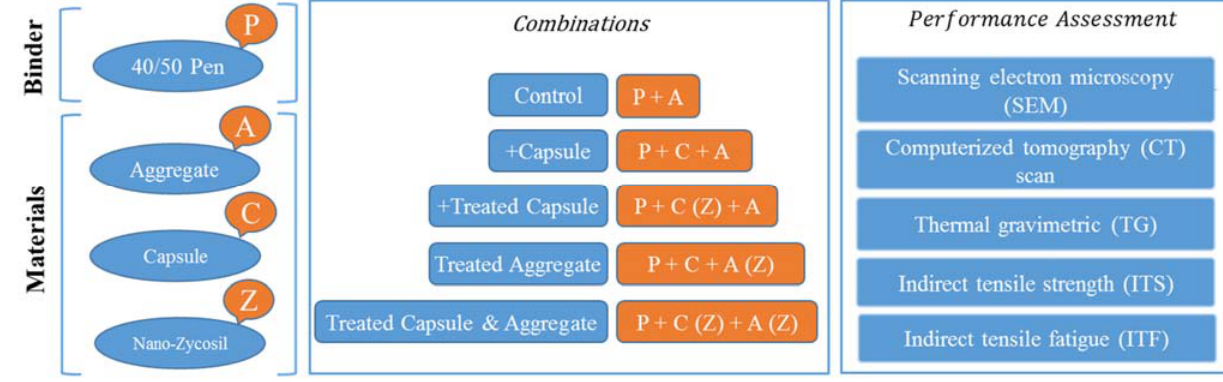
Figure 1: Chart of subjects of this